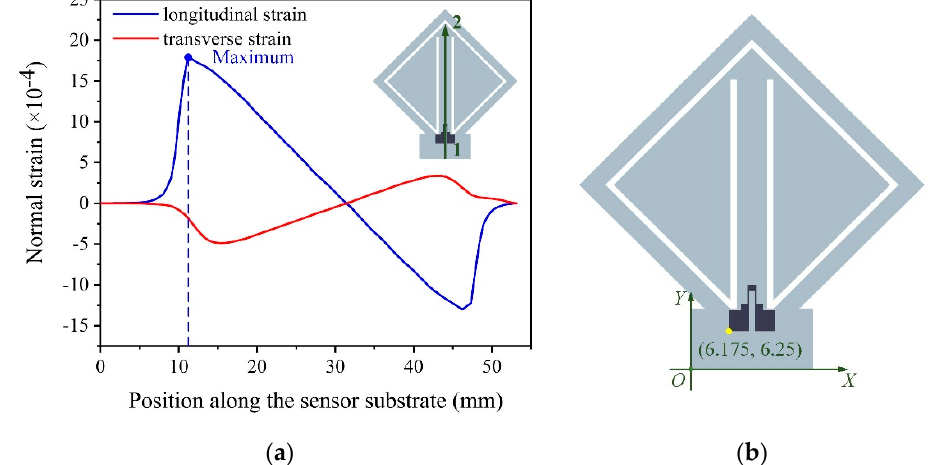
Figure 4. ( a ) The longitudinal strain and the transverse strain distributions along the path from point 1 to point 2 on the sensor substrate. ( b ) The position of the strain gauge on the sensor